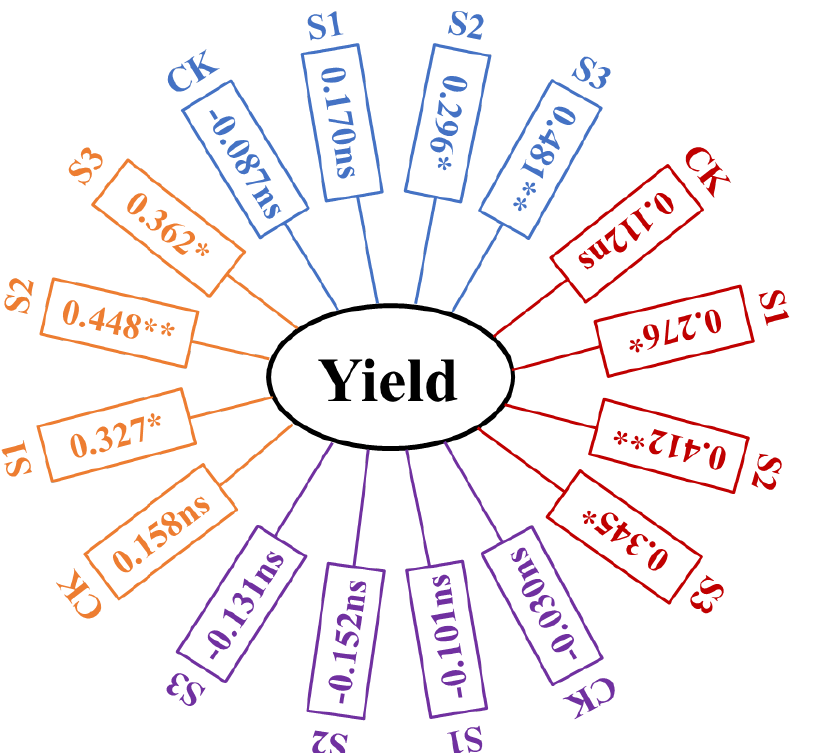
Figure 12. The correlation between root weight ratio (RWR, %), root length density (RLD, mm cm − 3 ), root surface area (RSA, m 2 m − 2 ), root length ratio (RLR, m g − 1 ) and yield of maize. *, ** significant differences at p < 0.05 and p < 0.01, respectively. ns represents no significant differences. Blue: RWR. Red: RLR. Purple: RSA. Orange: RLD.